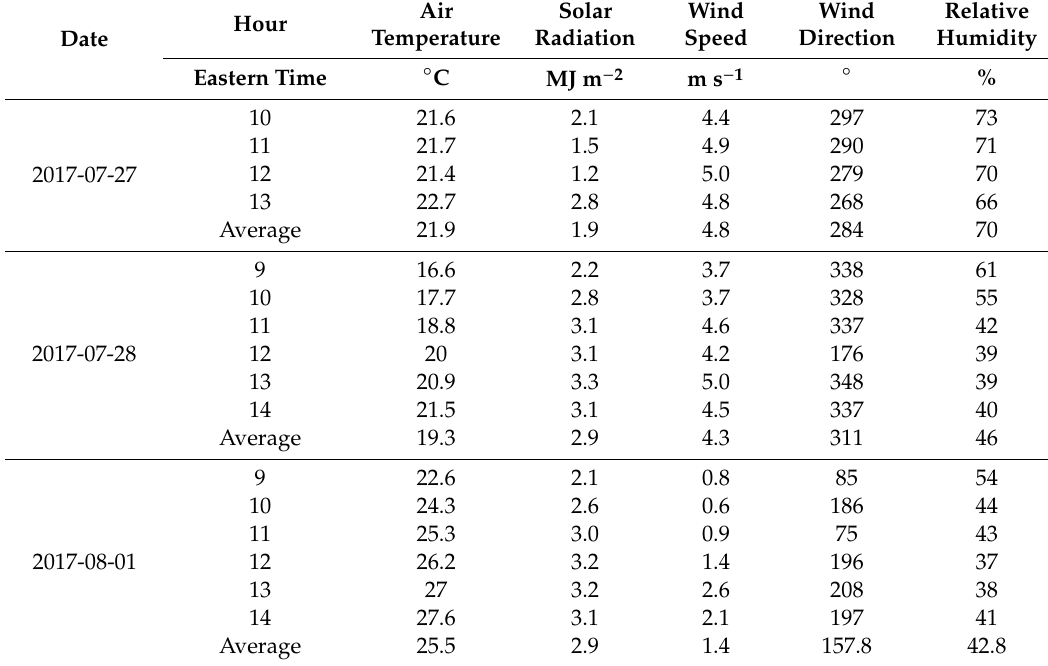
Figure 1. Site configuration with sensor positions. ( a ) Compost site overview, ( b ) lasers, reflectors and compost piles. ( c ) Wheat stubble field overview, ( d ) approximate positions of lasers, reflectors and sonic anemometer, and ( e ) photo of the lasers. Table 1. Hourly averaged air temperature, solar radiation, wind speed and relative humidity measured from the weather station near the composter.